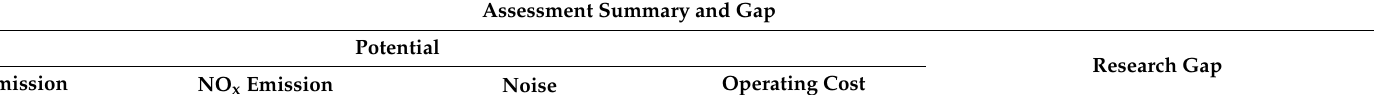
Table 9. Performance assessment summary and the